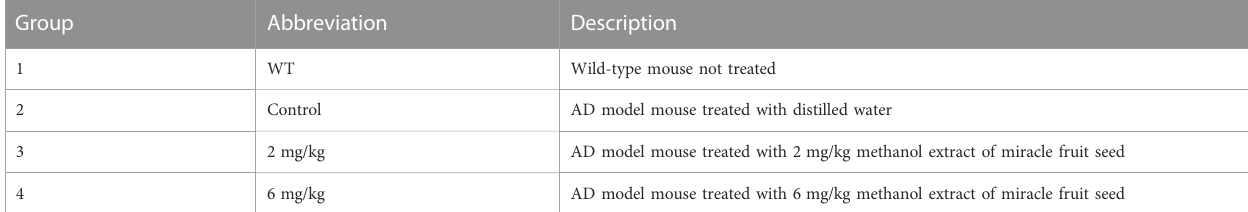
TABLE 1 Experimental groups of mice. Group